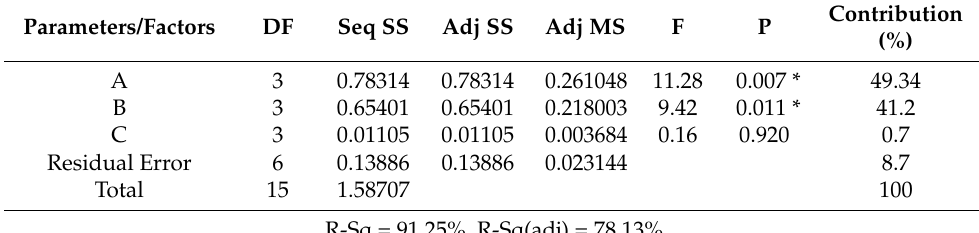
Table 7. ANOVA for peak load.